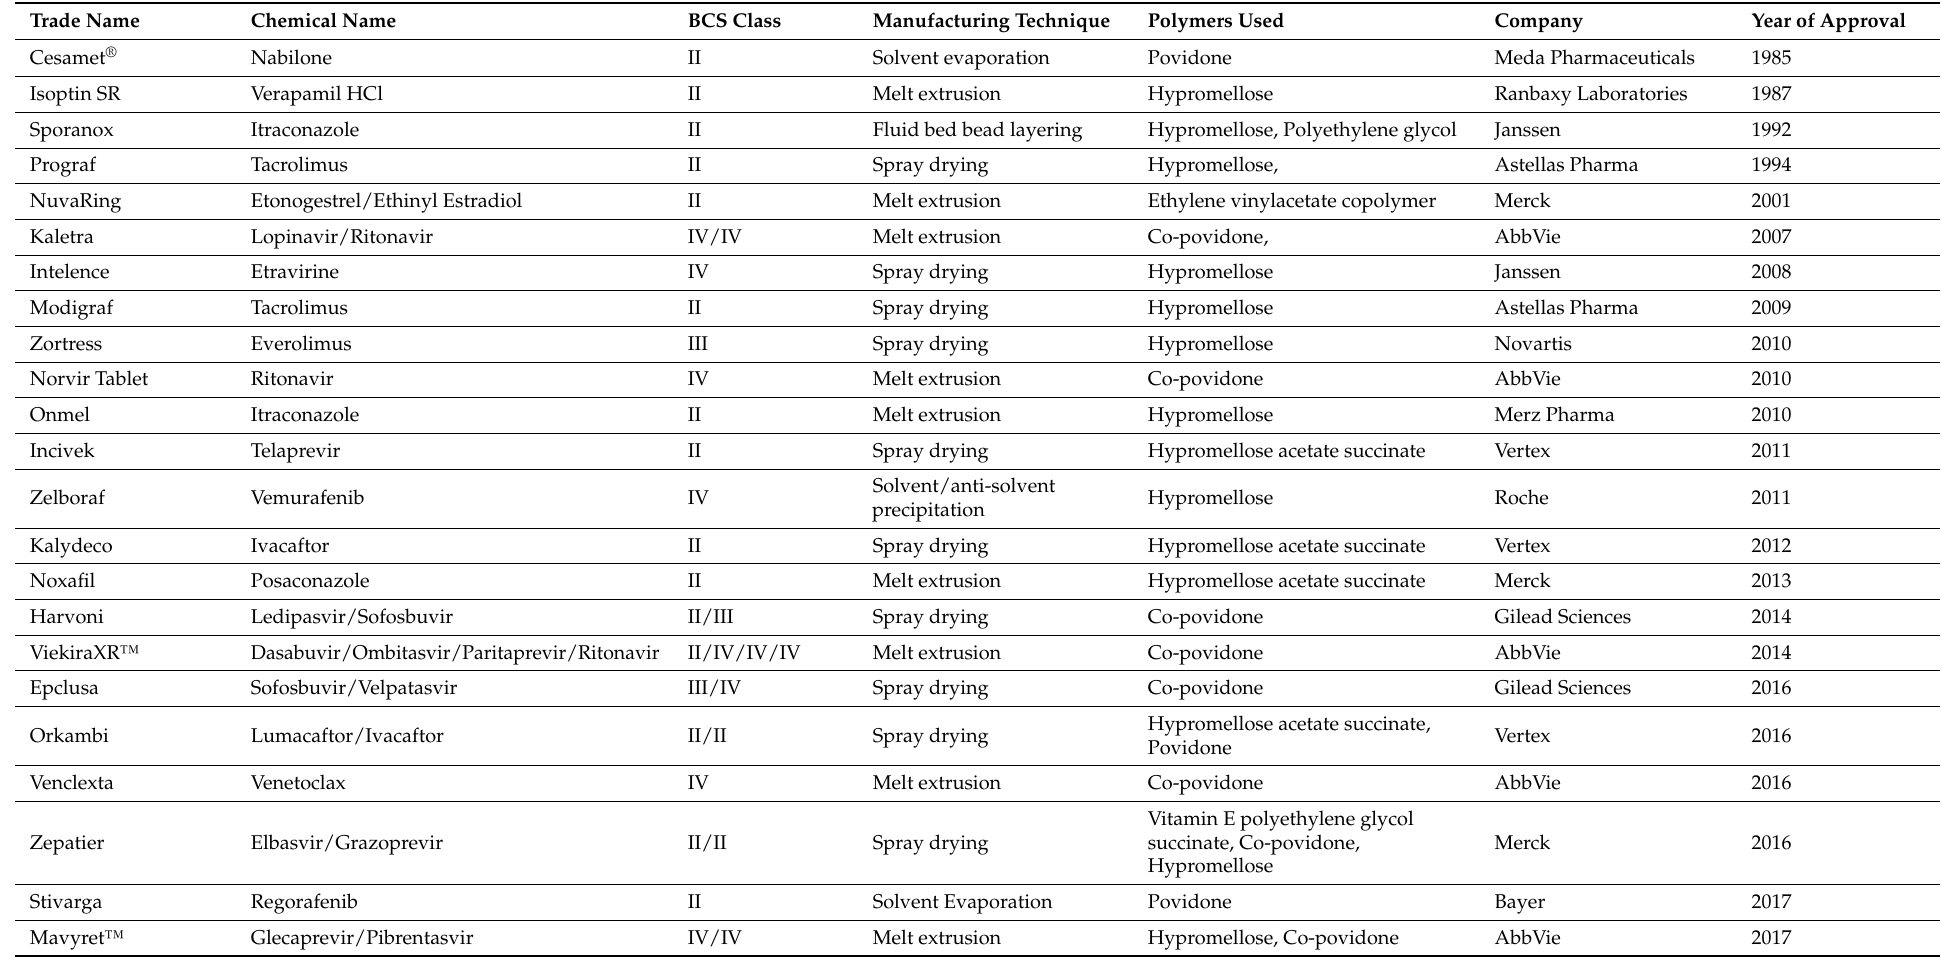
Table 1. Examples of FDA-approved amorphous solid dispersions products. Adapted from [18] under Creative Commons Attribution (CC BY-NC-ND 4.0) license,